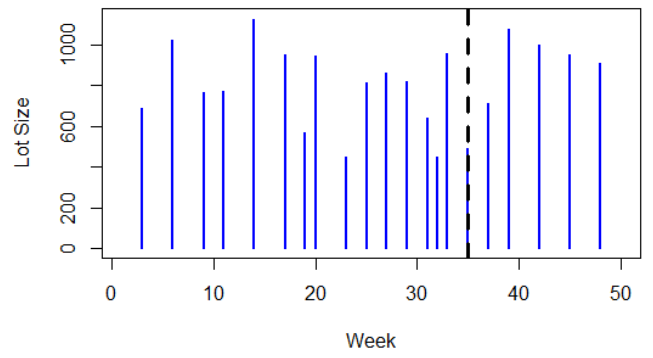
Figure 6. Dynamic replenishment plan until week 35.